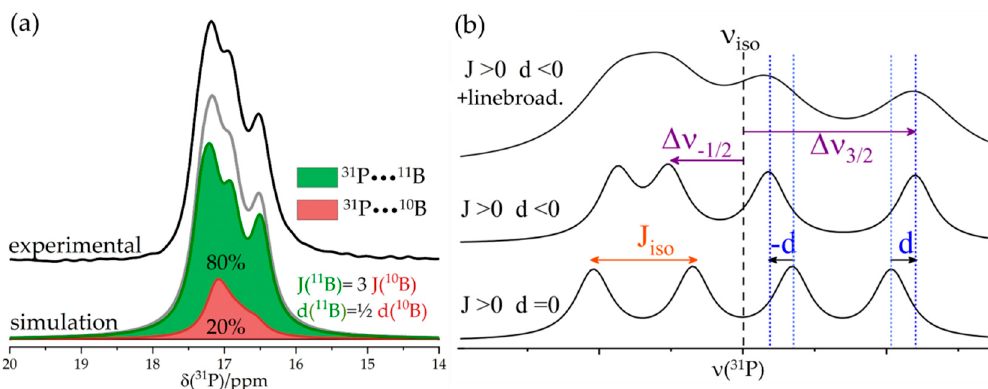
Figure 7. ( a ) Exemplary 31 P MAS NMR spectrum of a B / P FLP with isotropic 31 P J-couplings to 11 B (green) and 10 B (red) of 33 and 11 Hz, respectively, and residual dipolar couplings of 8 and 16 Hz. ( b ) Simulated MAS NMR spectra demonstrating the general shape for an S = ½ nucleus coupled to a quadrupolar I = 3 / 2 nucleus. Bottom spectrum: no quadrupolar interaction. Middle spectrum: with quadrupolar interaction, leading to an additional dipolar splitting parameter d arising from cross-terms between the quadrupolar interaction and the heteronuclear dipolar interaction. The dashed blue lines on the right hand side, each located at a peak maximum of the bottom or middle curve, show the relative shift of two resonances by the residual dipolar coupling d , which is negative for coupling of S to I with m I = ± 1 / 2 and, vice versa, positive for m I = ± 3 / 2. The overall change of the resonance frequency ∆ ν m caused by isotropic J -coupling and residual dipolar coupling d is exemplarily shown for resonances originating from couplings of S to I with m I = − 1 / 2 and m I = + 3 / 2. Top spectrum: simulated profile with additional line broadening to create a line shape similar to the experimental curve (shown in green in ( a )).